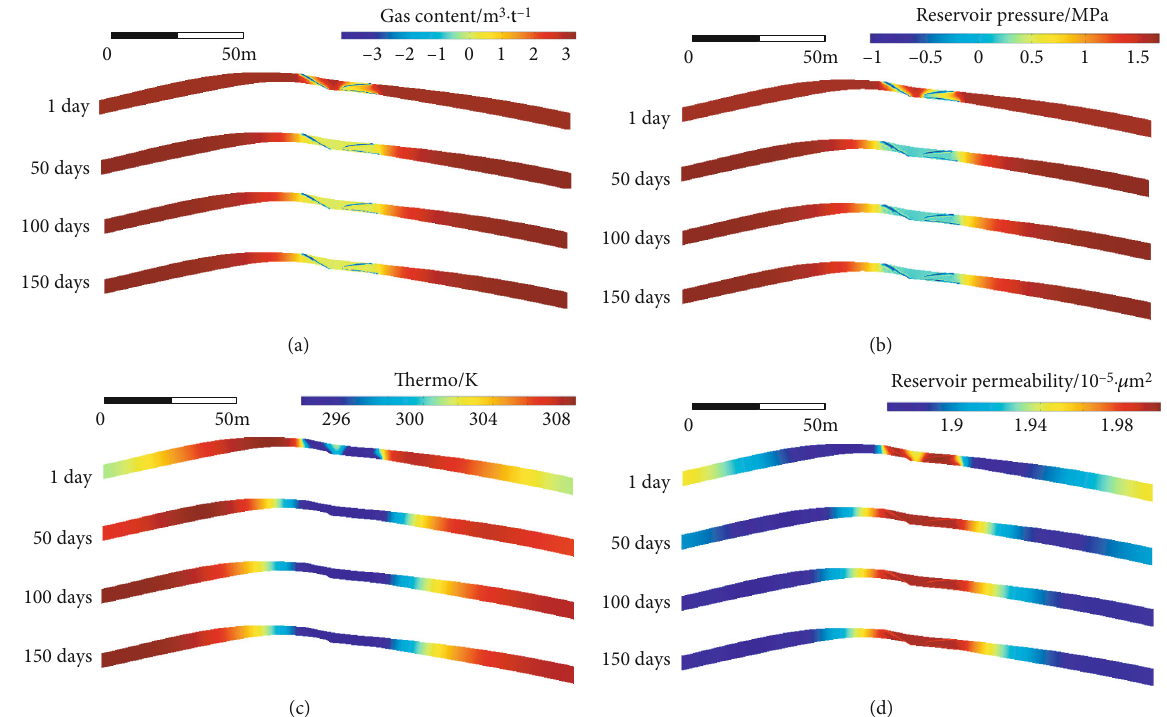
Figure 8: Multi fi eld evolutionary characteristics of THM near B1 anticline and F10 normal fault structures.